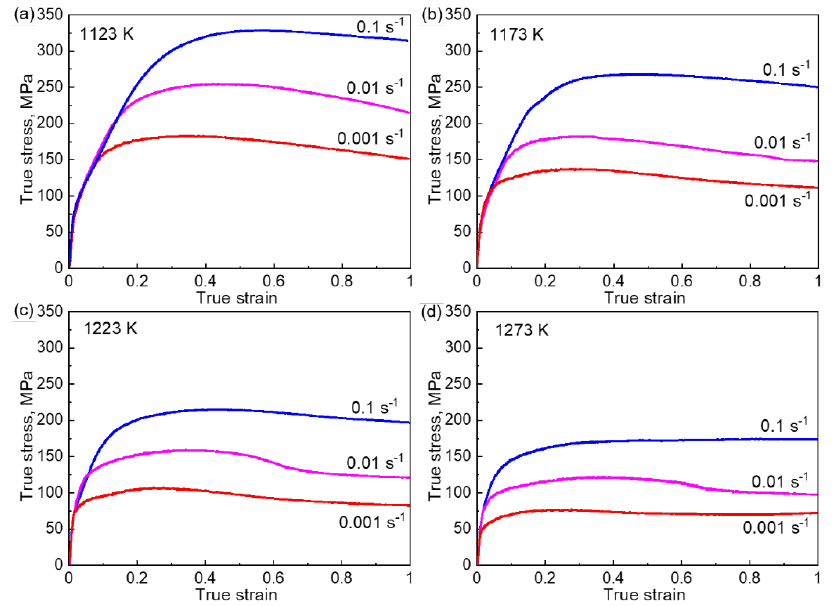
Figure 2. The true stress-strain curves of the Co 35 Cr 25 Mn 15 Ni 15 Fe 10 TRIP-HEA hot-compressed at ( a ) 1123 K, ( b ) 1173 K, ( c ) 1223 K, and ( d ) 1273 K. The strain rates were 0.1, 0.01, and 0.001 s −1 .